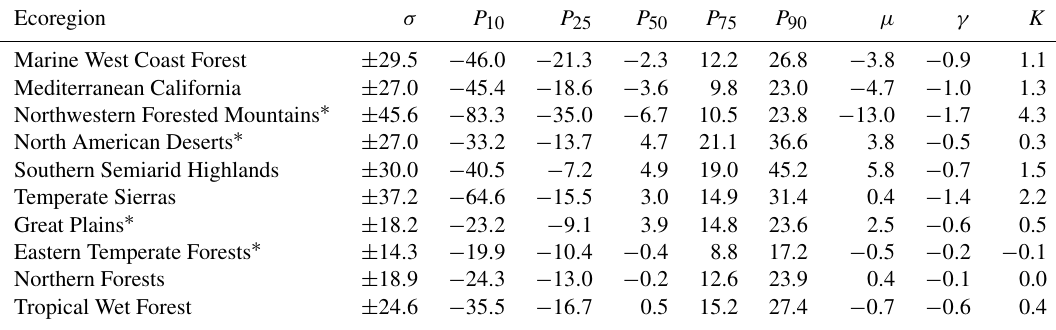
Table 4. Summary statistics of ecoregion water budget calculations summed for complete water years 2001–2010. Median ( P 50 ) and standard deviation ( σ ) summarize the iterative water budgets’ ( n = 2925) relative imbalances ( Rε ) in units of percent. The 10th, 25th, 75th, and 90th percentiles ( P i ) quantify the distribution ranges, along with skew ( γ ) and kurtosis ( K ). The ensemble column µ provides water budget Rε produced from the ensemble mean of all data sets available for water years